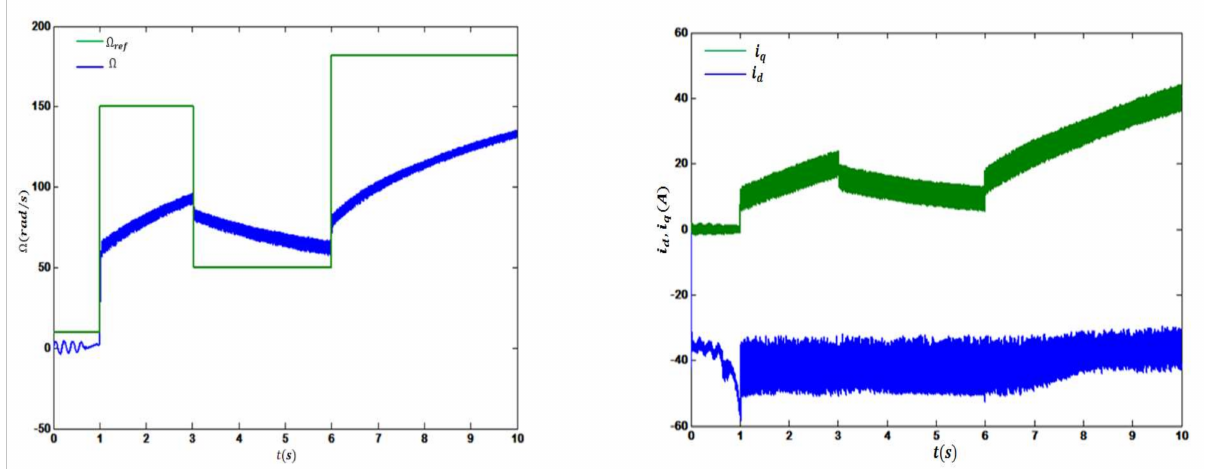
Figure 15. PMSM responses for the maximum power point MPP 2 , and for T = 25 ◦